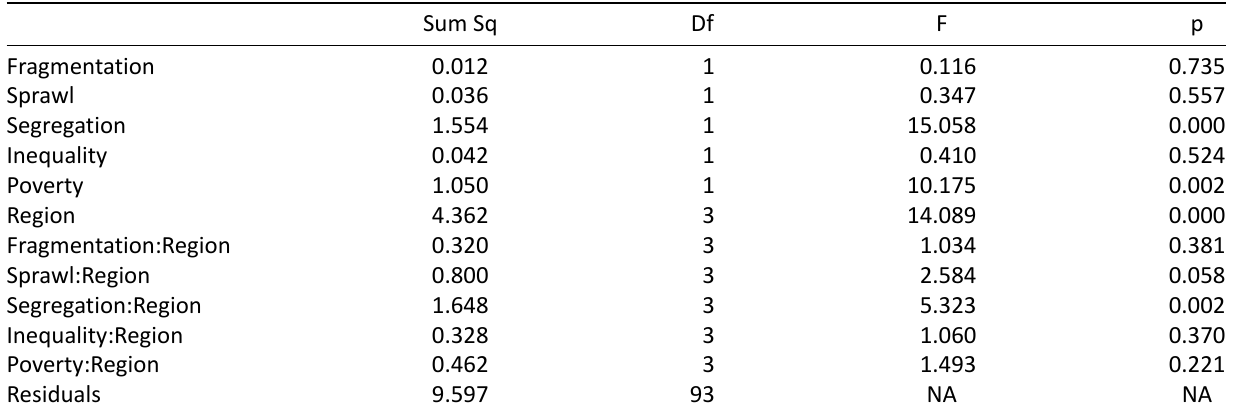
Table 5. Type II ANOVA for interaction